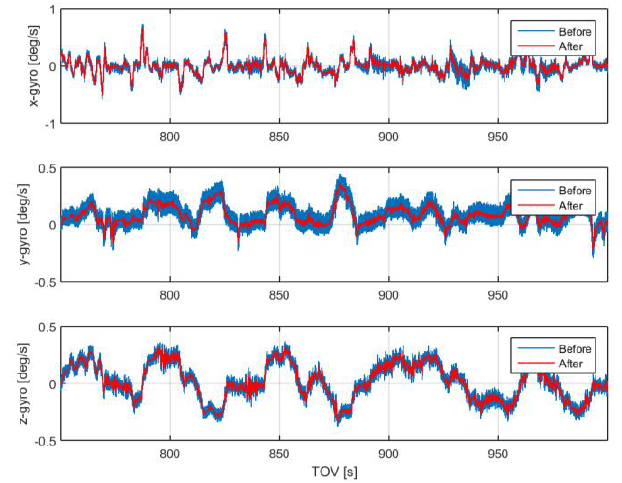
Figure 2. ADIS gyro measurements before and after de-noising